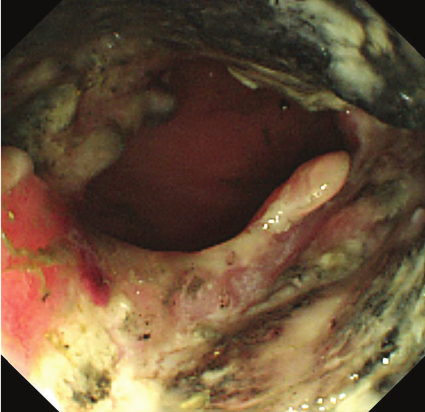
Figure 2: Colonoscopic findings of widely dispersed, completely round ulcerative lesions.